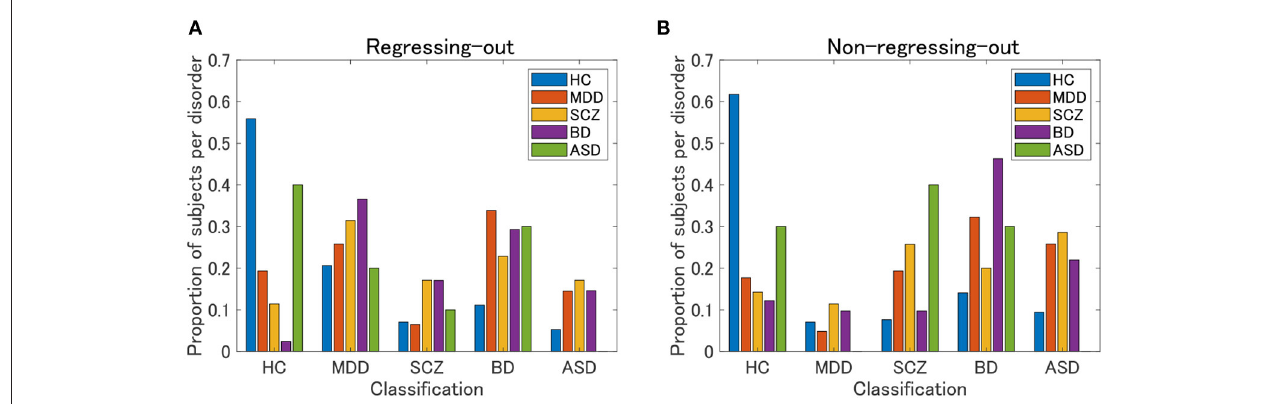
FIGURE 8 | Classification results of UTO subjects in the supervised approach. First, a classification model is built for each pair of psychiatric disorders, including HC, by applying elastic net classification to vectorized FC data. Second, based on the marginal probability yielded by these classification models, a subject is classified into one of the psychiatric categories. (A) FC is pre-processed by regressing-out of the effect of age and sex. (B) FC is not preprocessed.